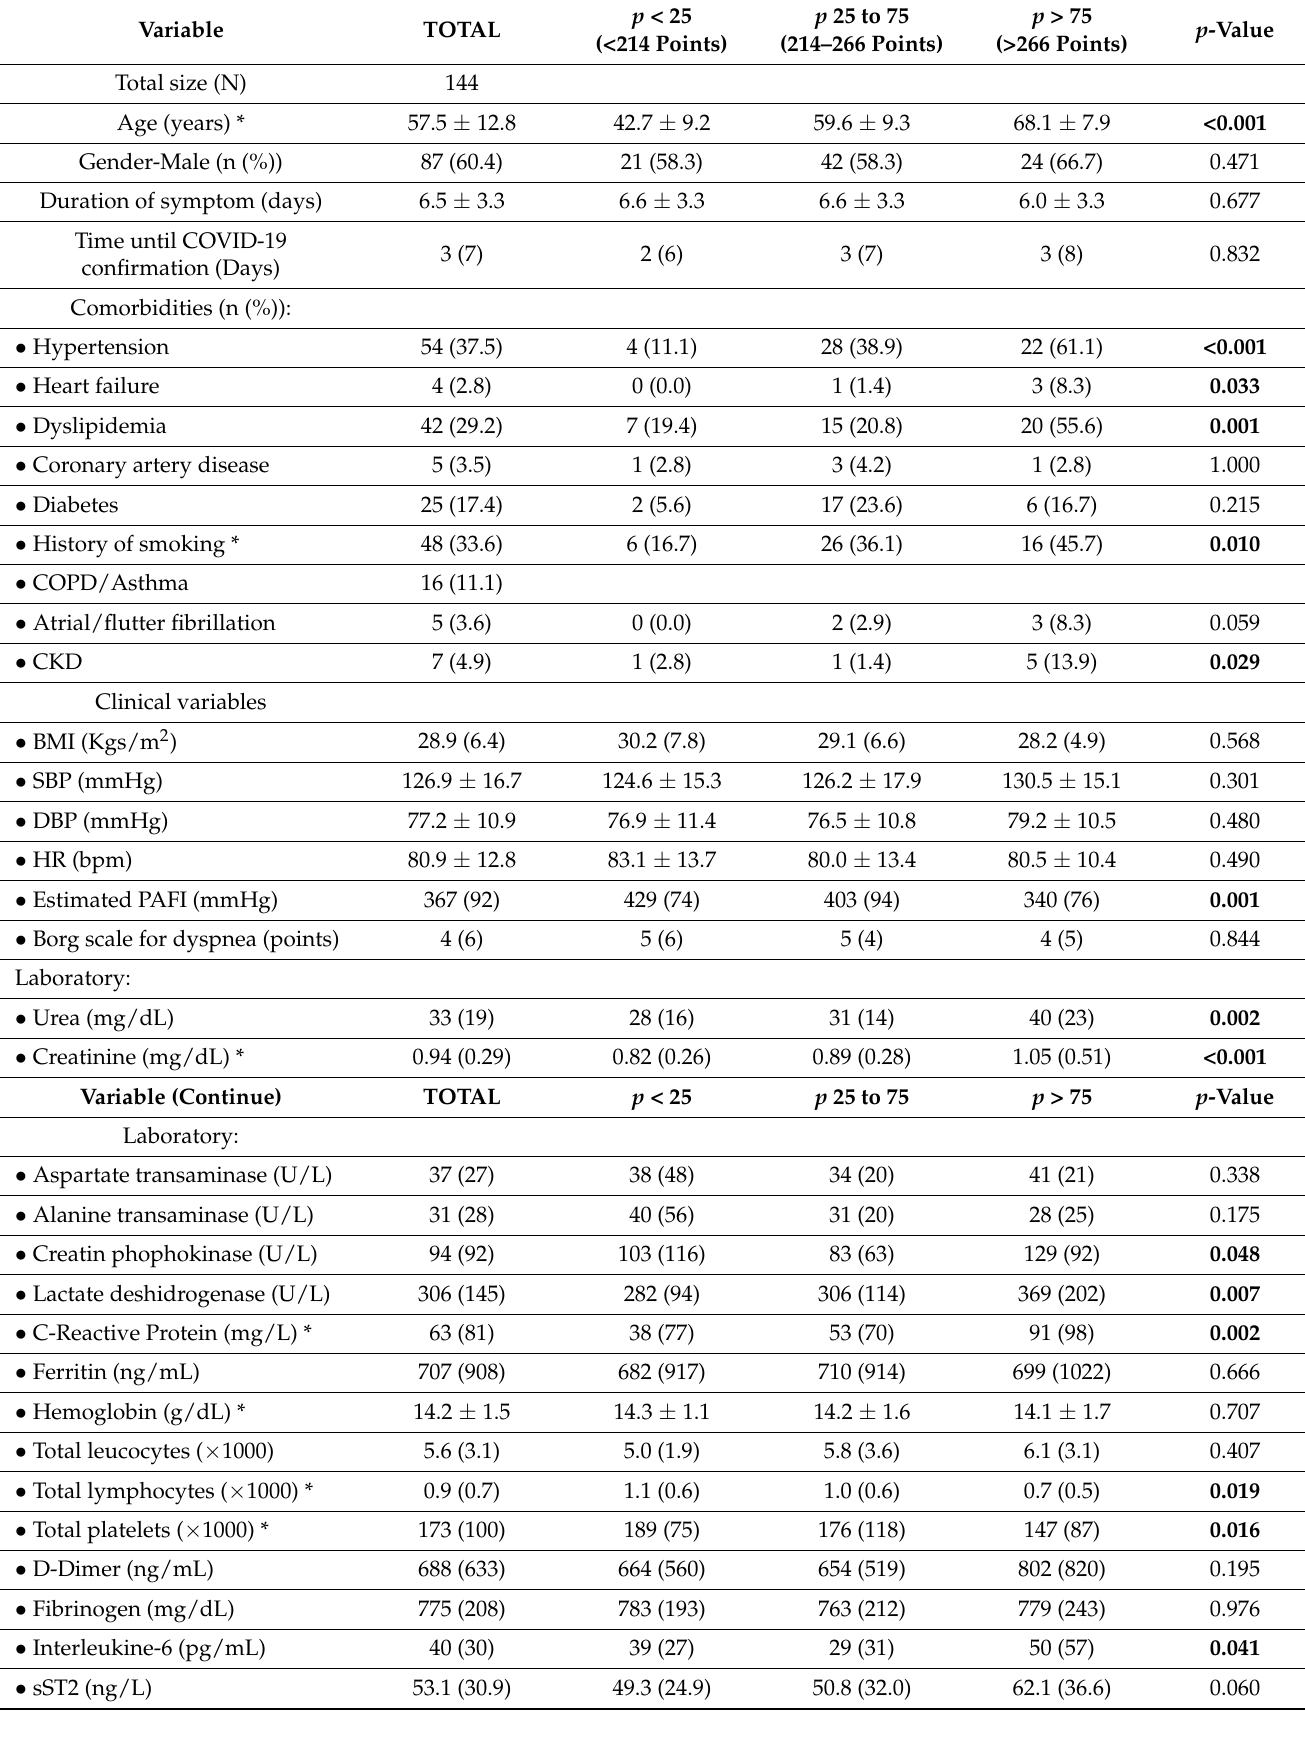
Table 1. Baseline characteristics according to PANDEMYC score (tertiles) at